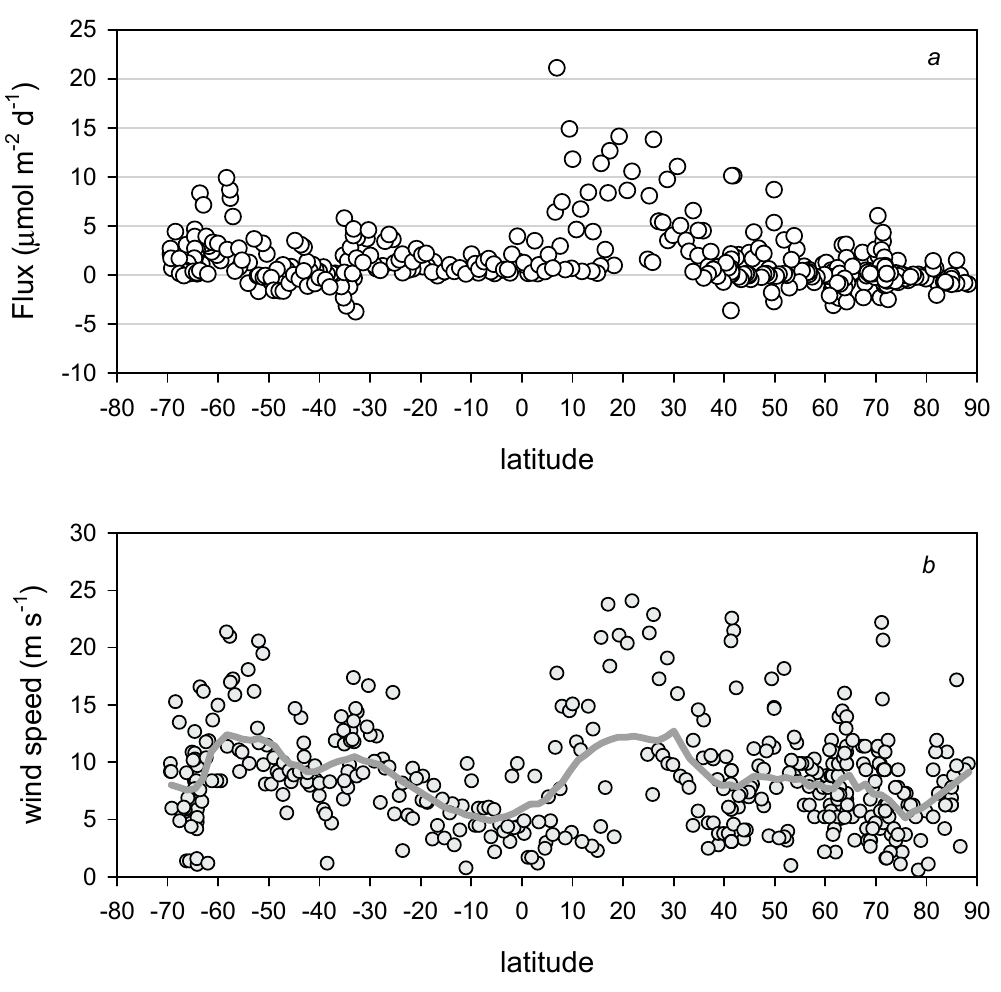
Figure 10. ( a ) The in situ air-sea N 2 O fluxes and ( b ) the in situ wind speed along the cruise tracks of both the 4th Chinese National Arctic Research Expedition and the 27th Chinese Antarctic Research